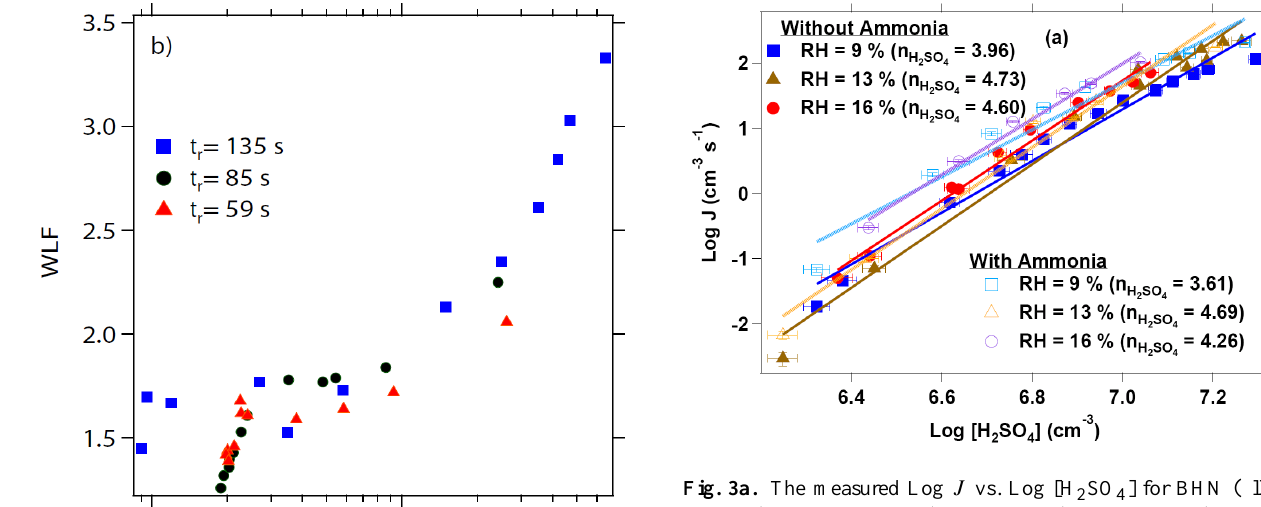
Fig. 3a. The measured Log J vs. Log [H 2 SO 4 ] for BHN (filled Figure 3a. The measured Log J vs. Log [H 2 SO 4 ] for BHN (filled symbols) and NH 3 -THN (open 634 symbols) and NH 3 -THN (open symbols) at RH=9% (squares), 13% (triangles), 16% (circles). [NH 3 ]=1.20ppbv for THN. The symbols) at RH = 9% (squares), 13% (triangles), 16% (circles). [NH 3 ] = 1.20 ppbv for THN. 635 horizontal and vertical bars indicate one standard deviation of The horizontal and vertical bars indicate one standard deviation of [H 2 SO 4 ] and J ; the solid or 636 [H 2 SO 4 ] and J ; the solid or dashed lines show the liner fitting curve dashed lines show the liner fitting curve of the data. 637 of the